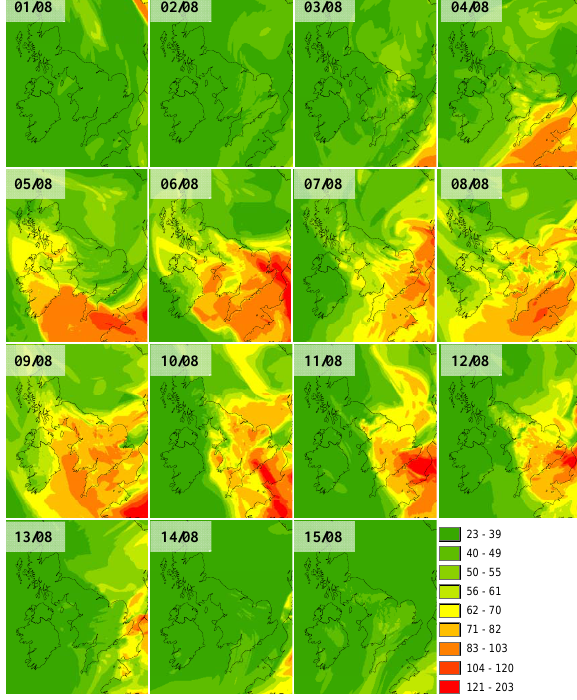
Fig. 6. EMEP4UK surface daily maximum ozone (ppb) for the first 15 days of August Figure 6: EMEP4UK surface daily maximum ozone (ppb) for the first 15 days of August